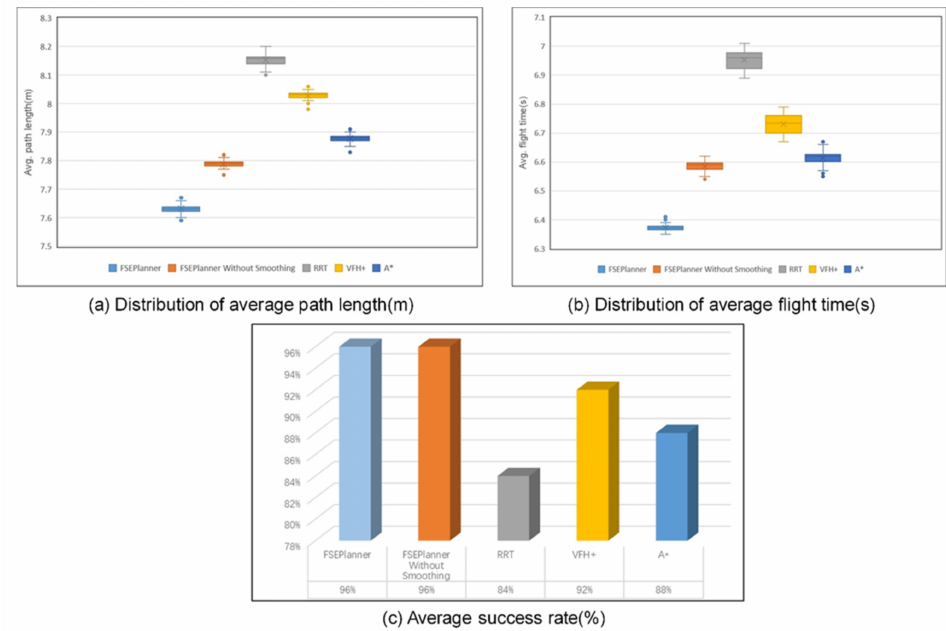
Figure 18. Results of the comparison between the RRT, A*, VFH+, proposed FSEPlanner without Smoothing and FSEPlanner algorithm in ( a ) Distribution of average path length (m), ( b ) Distribution of average flight time(s) and ( c ) Average success rate (%) in apartment